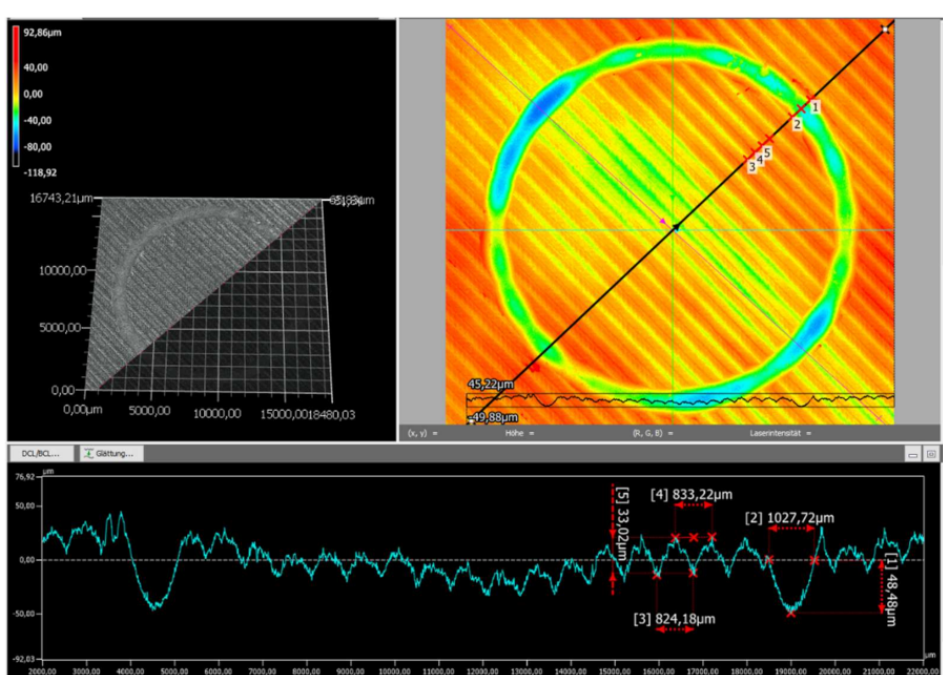
Figure 7. The wear profile of the natural PLA test specimen printed at 210 ◦ C.